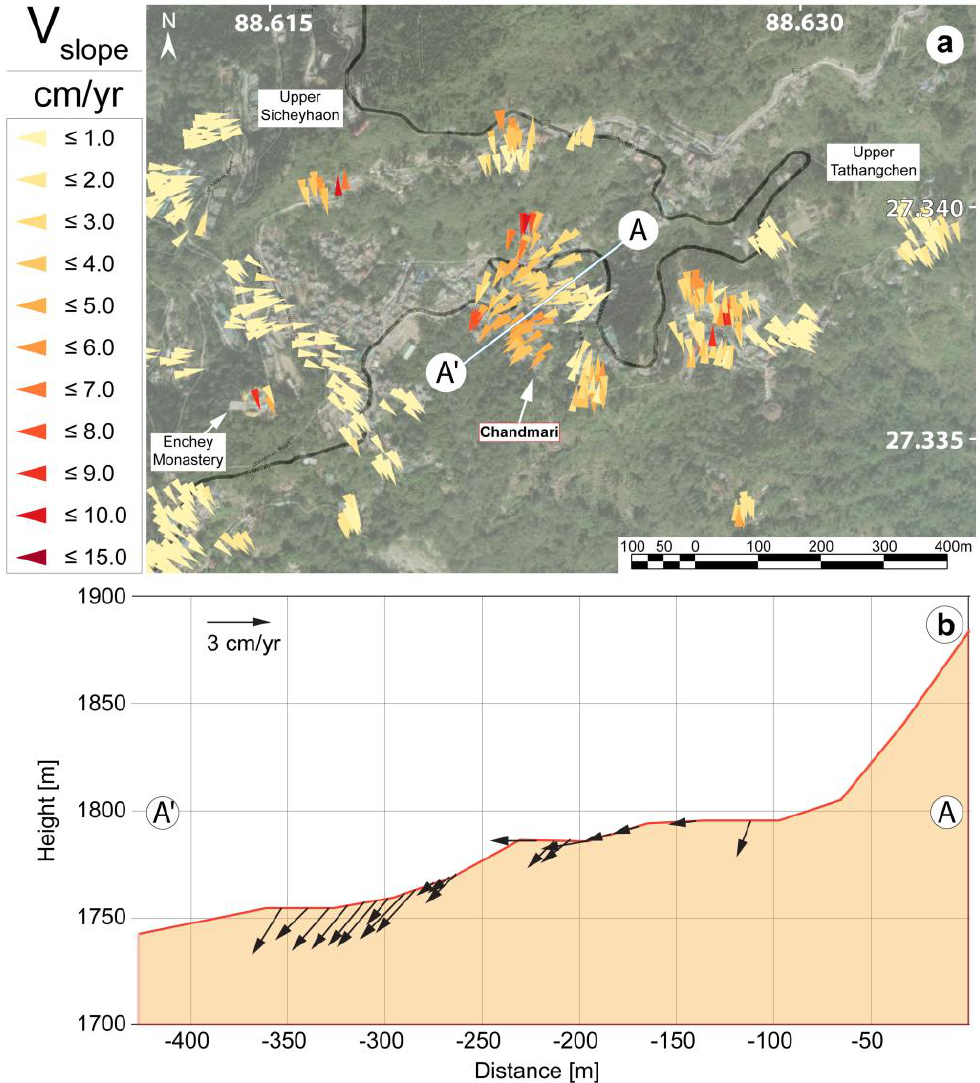
Figure 5. ( a ) A profile line along the Chandmari area in eastern Gangtok, where the typical rate of movements are in the range of 3 – 6 cm/yr with a maximum of 10 cm/yr. ( b ) Typical displacements